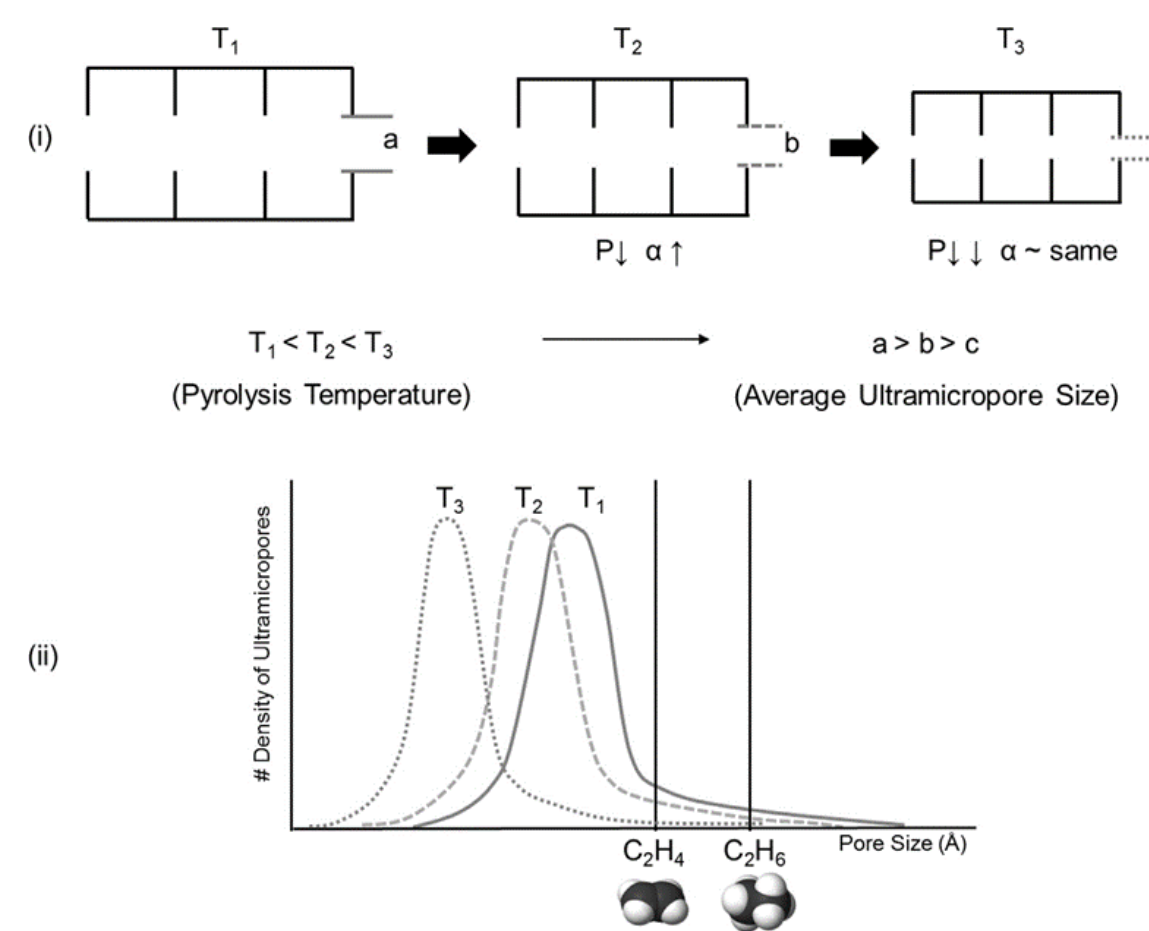
Figure 7. Effect of pyrolysis temperature on ( i ) CMS structure and ( ii ) Ultramicropore distribution. ( α = flow direction). Adapted from [81] with permission. Copyright (2015) Elsevier.